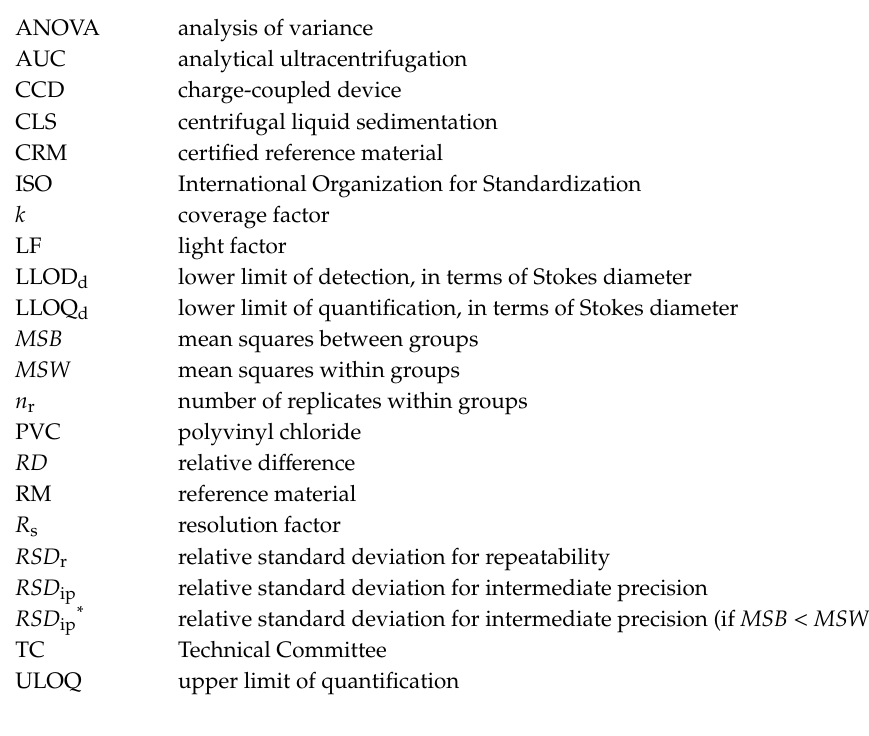
Figure S1: Light transmission profiles obtained for ERM-FD305 and using polycarbonate cuvettes of two di ff erent optical path lengths: (a) 2 mm, (b) 10 mm; Figure S2: Transmission signals obtained for ERM-FD305, without and after dilution with purified water: (a) 1.5 g / kg (without dilution), (b) 1.0 g / kg, (c) 0.5 g / kg; Table S1: E ff ect of cuvette type on measured particle size of ERM-FD305; Table S2: E ff ect of dilution on measured particle size; Table S3: Sedimentation times obtained for silica RMs of di ff erent particle sizes; Table S4: Data acquisition program for silica particles ( x St = 20 nm to 200 nm); Table S5: E ff ect of light factor (LF) on measured particle size of selected CRMs; Table S6: E ff ect of setting the meniscus based on the first and last transmission profiles; Table S7: E ff ect of measurement position on calculated particle size results for ERM-FD305; Table S8: E ff ect of background subtraction procedure (blank sample vs. last profile) on measured particle size of selected